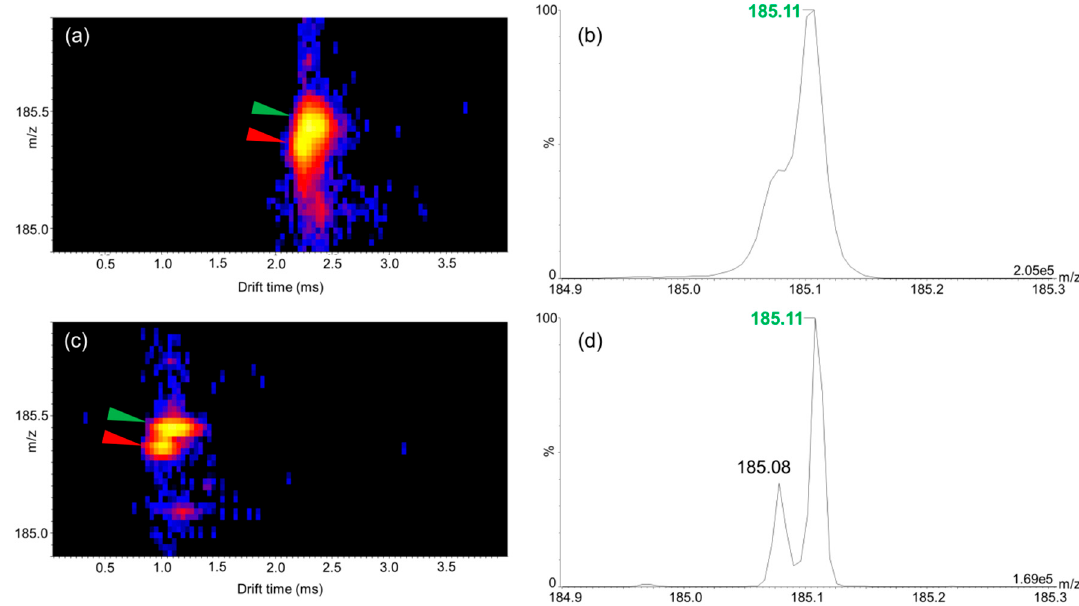
Figure 3. Matrix-assisted laser desorption/ionization–ion mobility–tandem mass spectrometry (MALDI–IM–MS/MS) analyses of liquid–liquid extraction extracts from plasma spiked with 1000 ng/mL of osimertinib. ( a ) Mass /charge ( m/z ) vs. drift time (DT) map in m/z 184.9 to 185.9 and DT 0 to 4 ms ranges in sensitivity mode. ( b ) Mass spectrum in m/z 184.9 to 185.3 range in sensitivity mode. ( c ) m/z vs. DT map in m/z 184.9 to 185.9 and DT 0 to 4 ms ranges in resolution mode. ( d ) Mass spectrum in m/z 184.9 to 185.3 range in resolution mode. In ( a ) and ( c ), green arrows indicate the fragment ion of osimertinib and red arrows the interfering fragment ion. The maximum intensities are given in arbitrary units at the bottom right of each spectrum in ( b ) and ( d ).